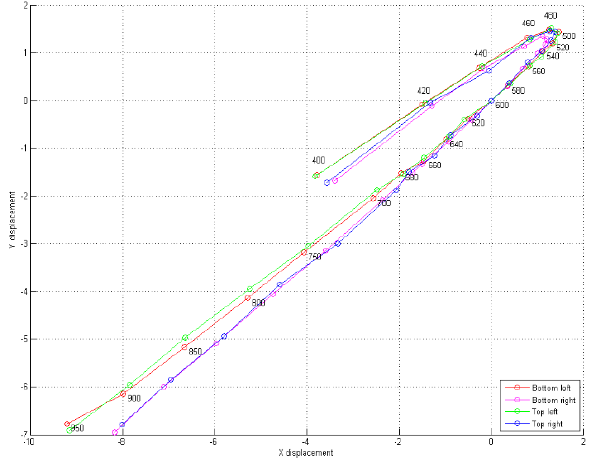
Figure 14. Trajectory of four target centroids in the image plane, showing effect of chromatic aberration in the